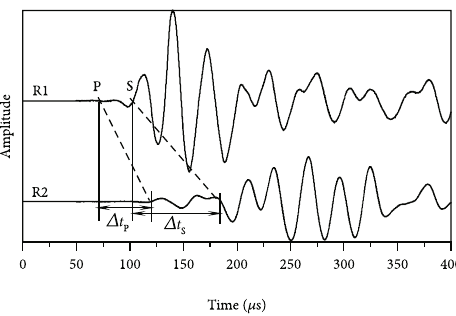
Figure 5: The received waveforms from one borehole model. The di ff erential arrival times of P- and S-waves between the two receivers (R1 and R2 in Figure 4) are used to calculate the wave